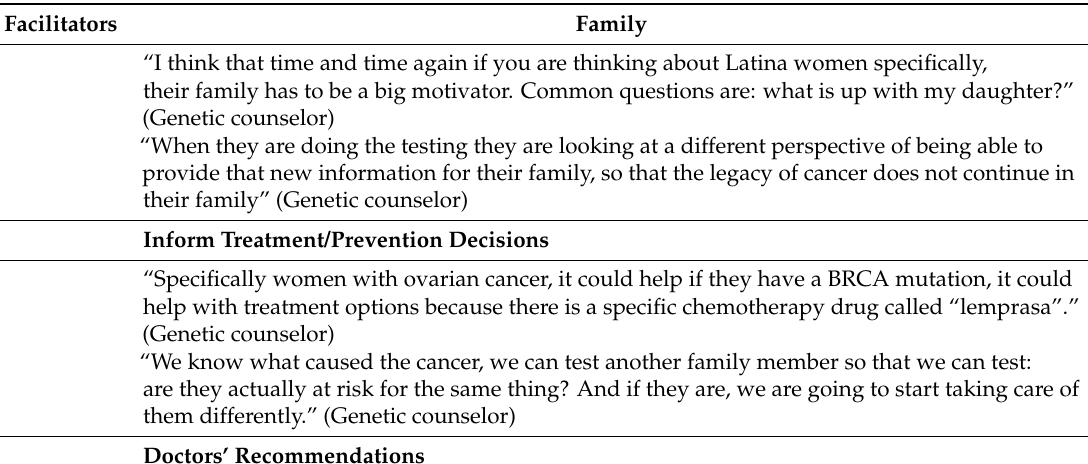
Table 1. Facilitators and Barriers to Participate in genetic cancer risk assessment